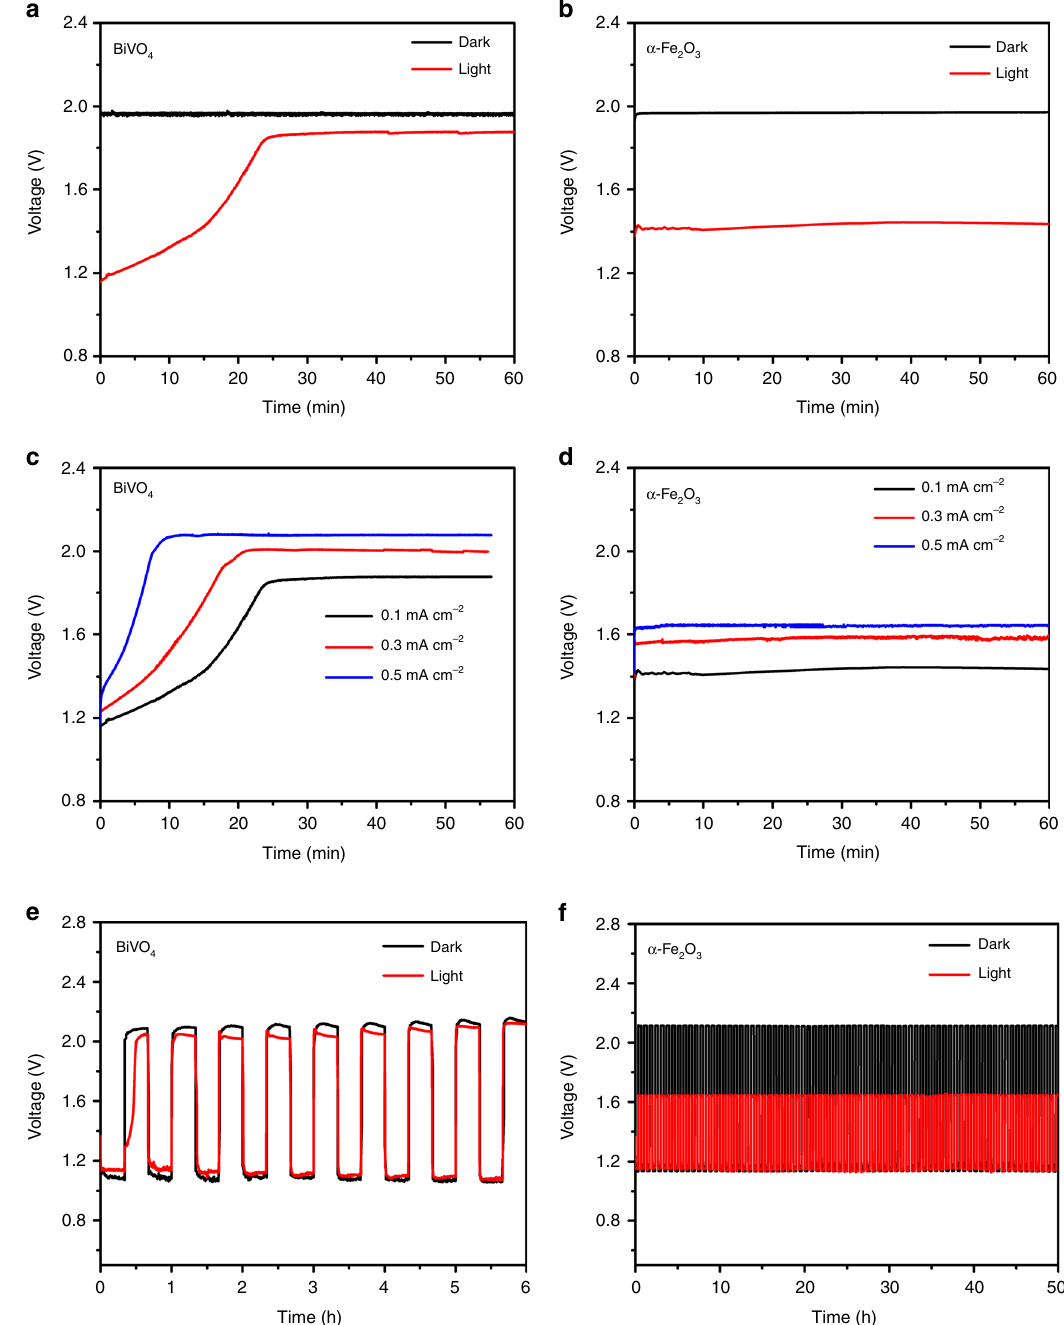
Fig. 5 Electrochemical characterizations of the sunlight-promoted rechargeable zinc – air battery. The charging curves of a zinc – air battery in the dark and under illumination with a BiVO 4 and b α -Fe 2 O 3 air photoelectrode, respectively, at a current density of 0.1 mA cm − 2 . The charging curves of a Zinc – air battery with c BiVO 4 and d α -Fe 2 O 3 air photoelectrode, respectively, at the current density of 0.1, 0.3, and 0.5 mA cm − 2 under illumination. Cycling performance of sunlight-promoted rechargeable zinc – air battery in the dark and under illumination with e BiVO 4 and f α -Fe 2 O 3 air photoelectrode, respectively, at a current density of 0.5 mA cm −